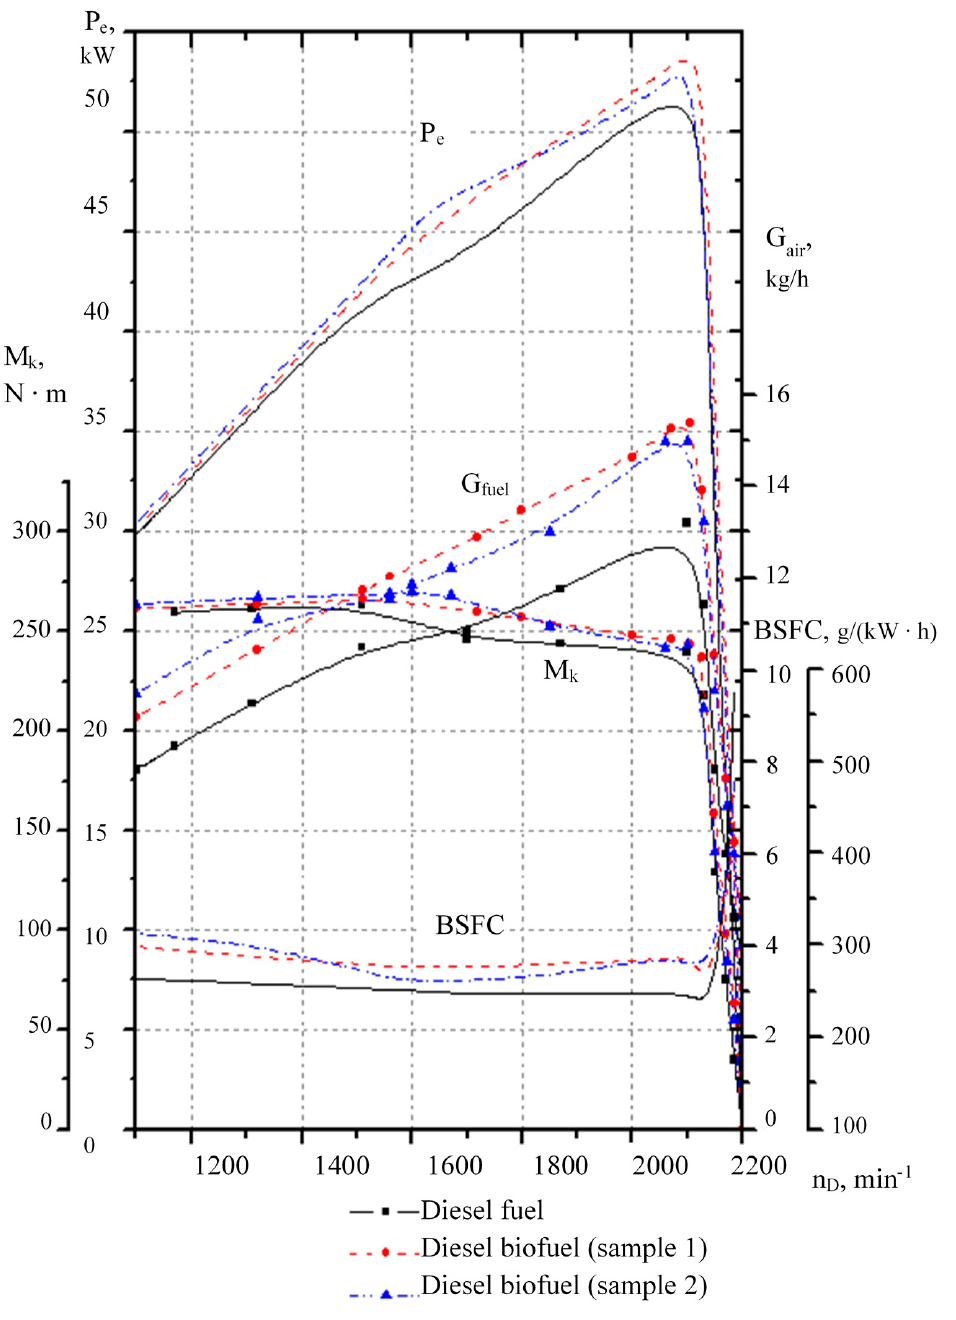
Figure 3. External speed characteristics of the D-241 diesel engine.